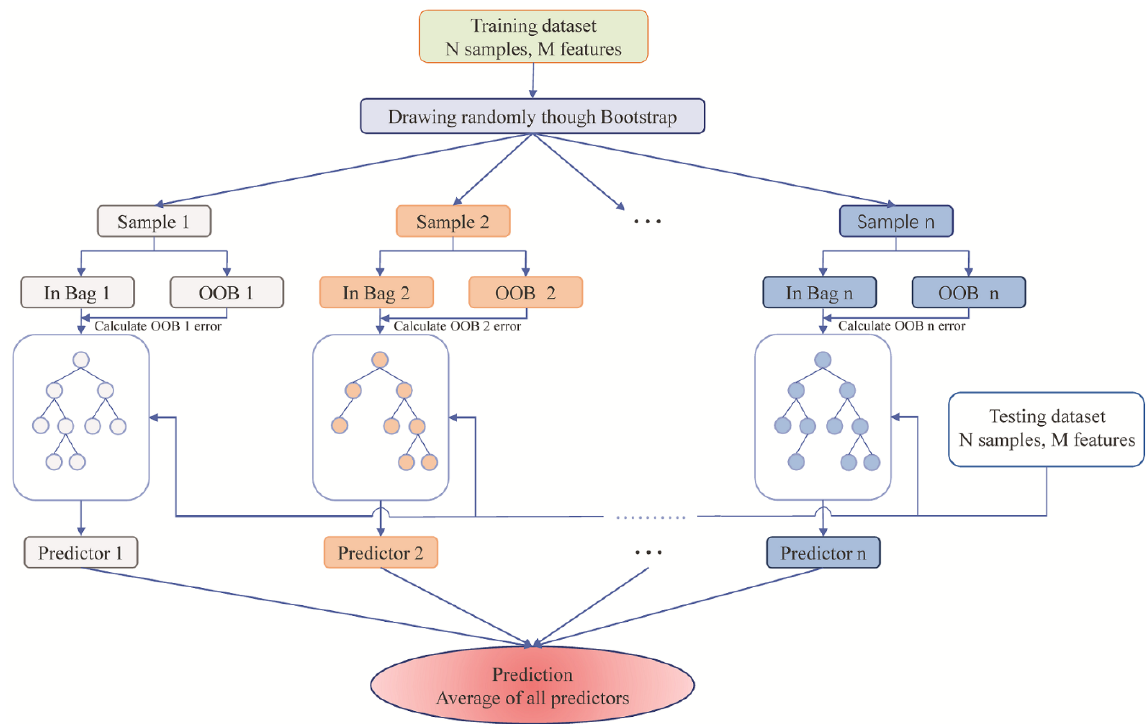
Figure 1. The structure of the random forest algorithm.